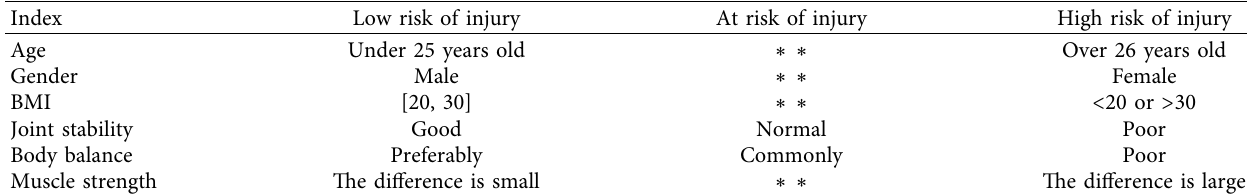
Table 1: Risk assessment of internal injury factors.